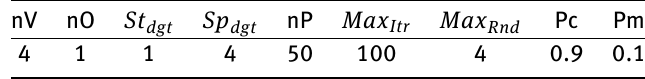
Table 25: VSSCGA Settings for Powel’s function with 4 variables